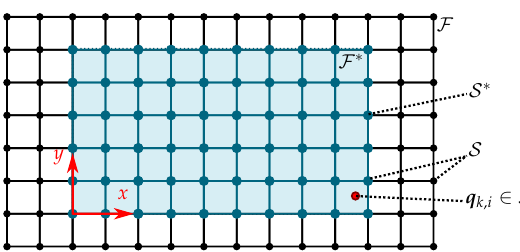
Figure 4. The agent’s position q k , i at the discrete time step k lies in a spatial field F ∗ with coordinate values x and y . The field F ∗ can be extended to F and is then discretized into a regular grid S to enable the construction of a GMRF and to compensate for boundary